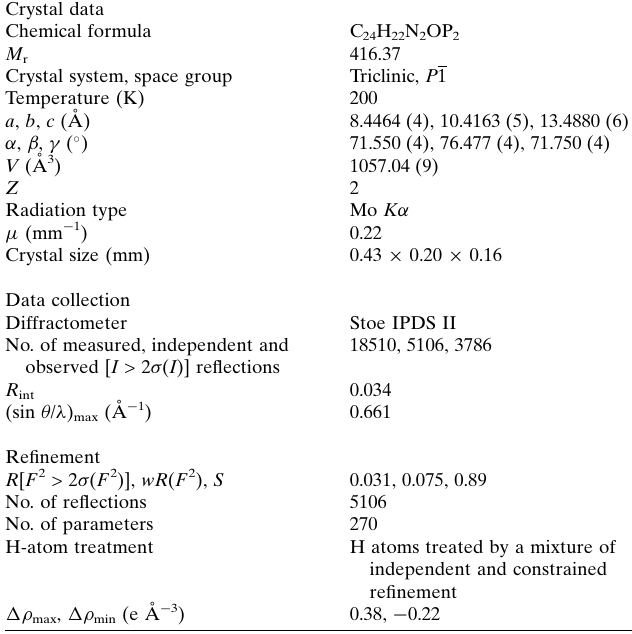
Table 2 Experimental details. Crystal data Chemical formula